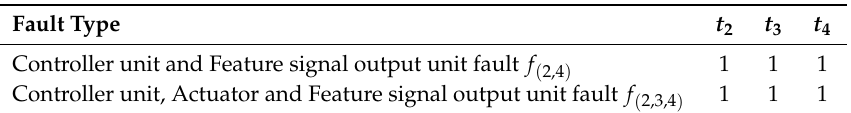
Table 4. Fault ambiguity group of the control